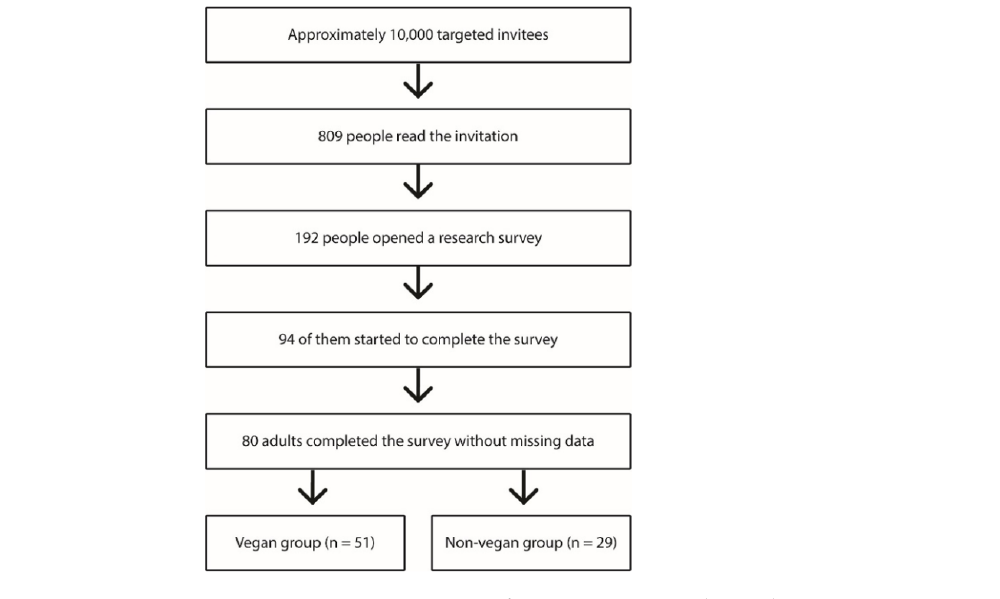
Figure 1. Recruitment process for participation in the study.